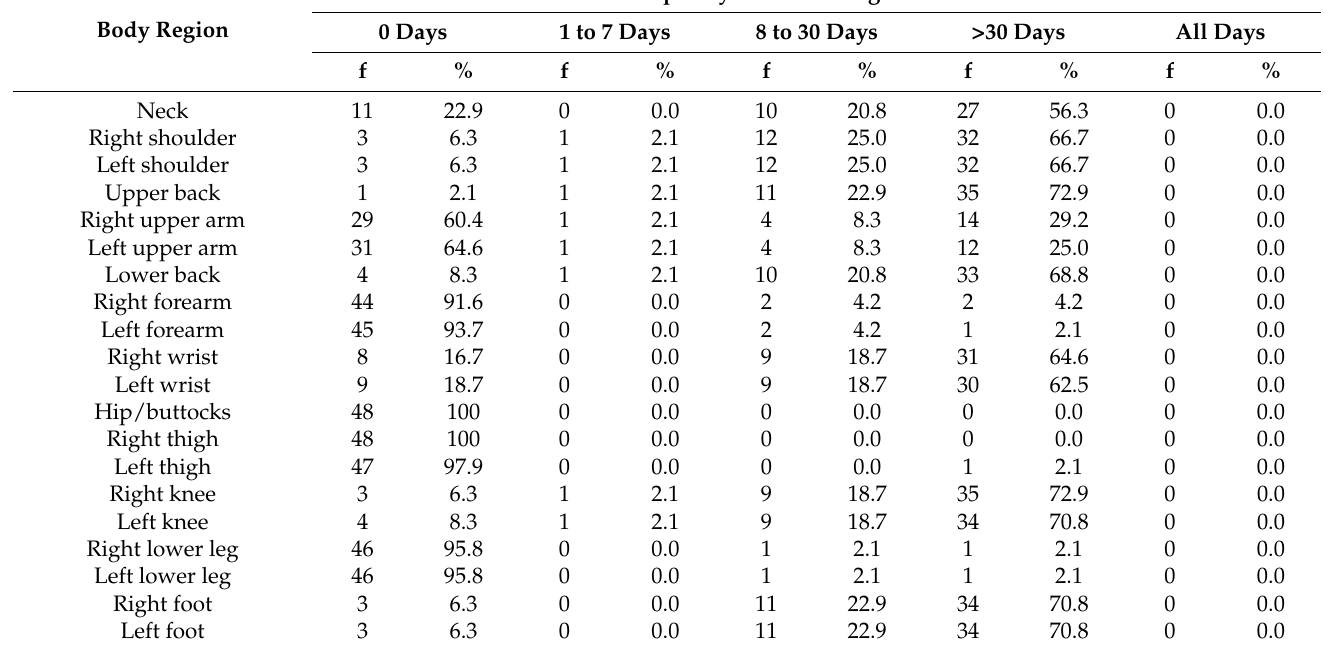
Table 4. Frequency (f) and percentage (%) of workers who perceived musculoskeletal symptoms by body region according to number of days during the last 12 months ( n = 48).